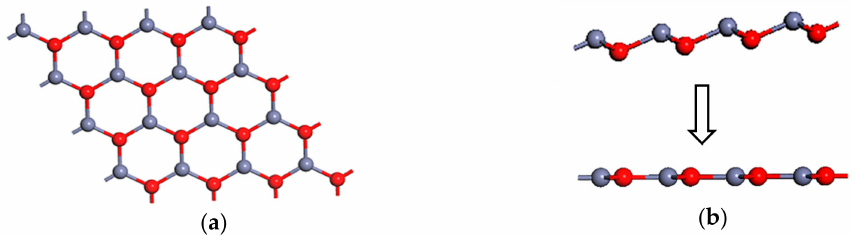
Figure 1. Graphene-like ZnO ML with 4 × 4 × 1 supercell. ( a ) The top view, ( b ) the side view of the original and the optimized